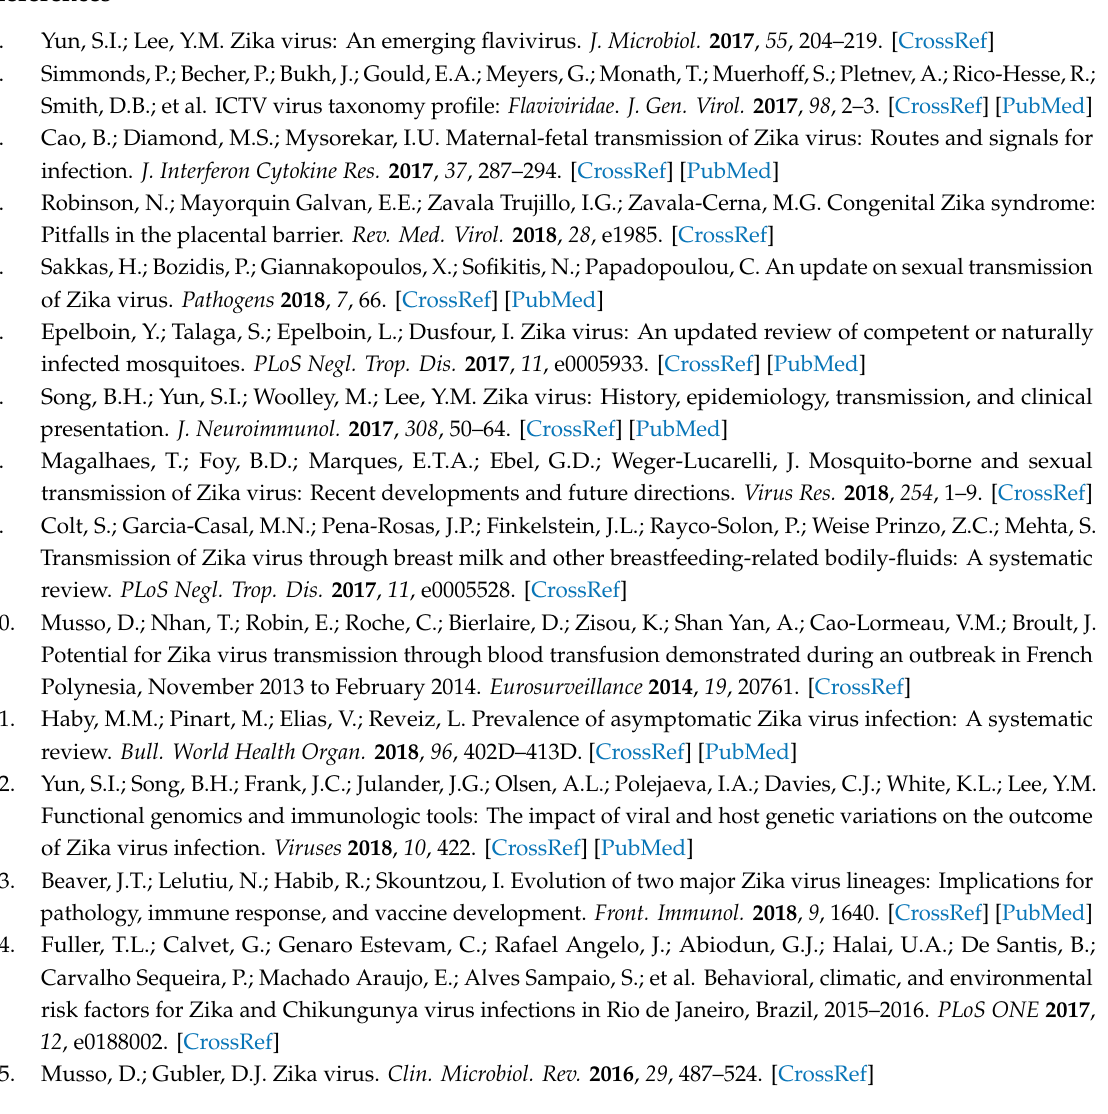
Figure S1: ZIKV lacks the ribosomal frameshift signal directing the expression of NS1 (cid:48)